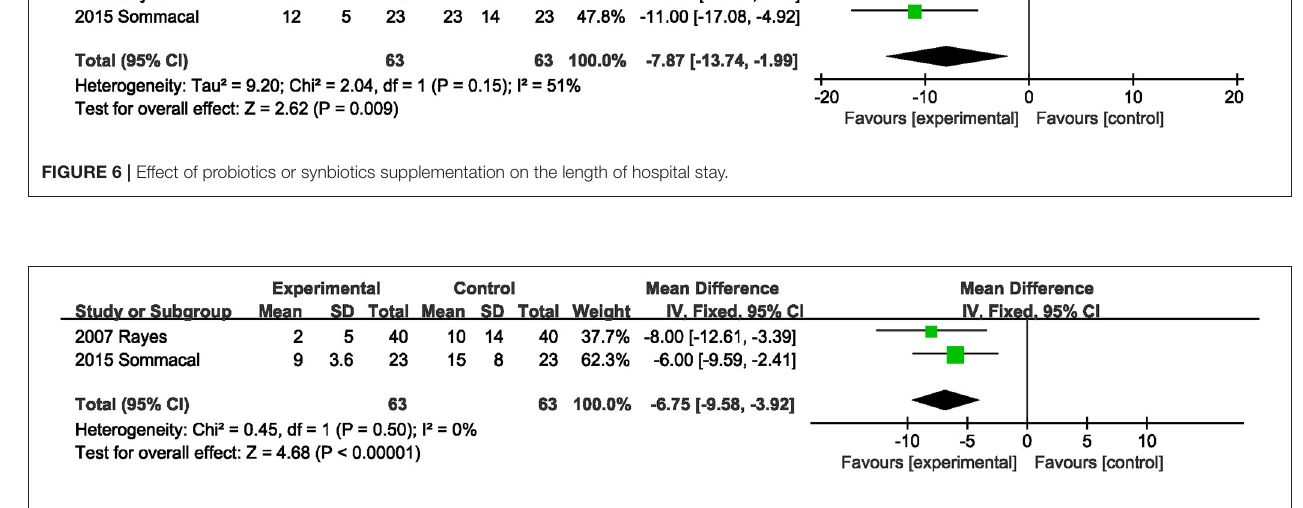
FIGURE 7 | Effect of probiotics or synbiotics supplementation on the antibiotic